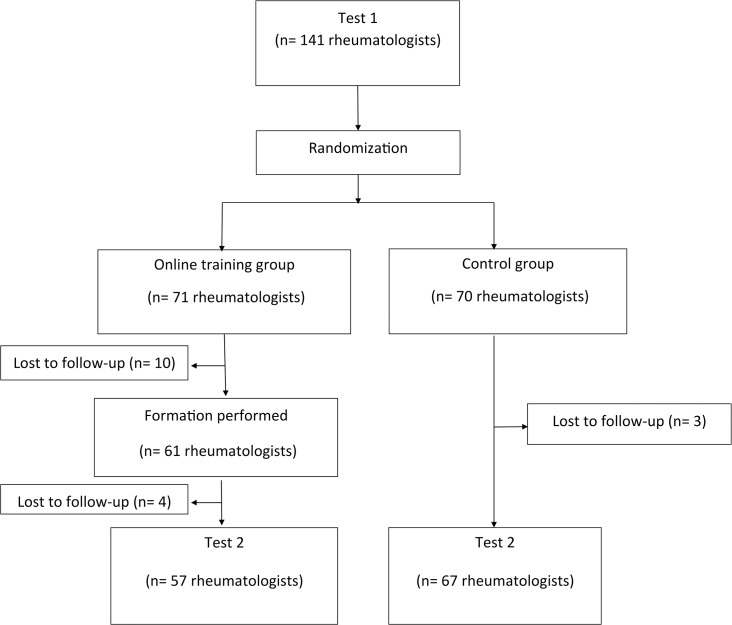
Study flow chart.